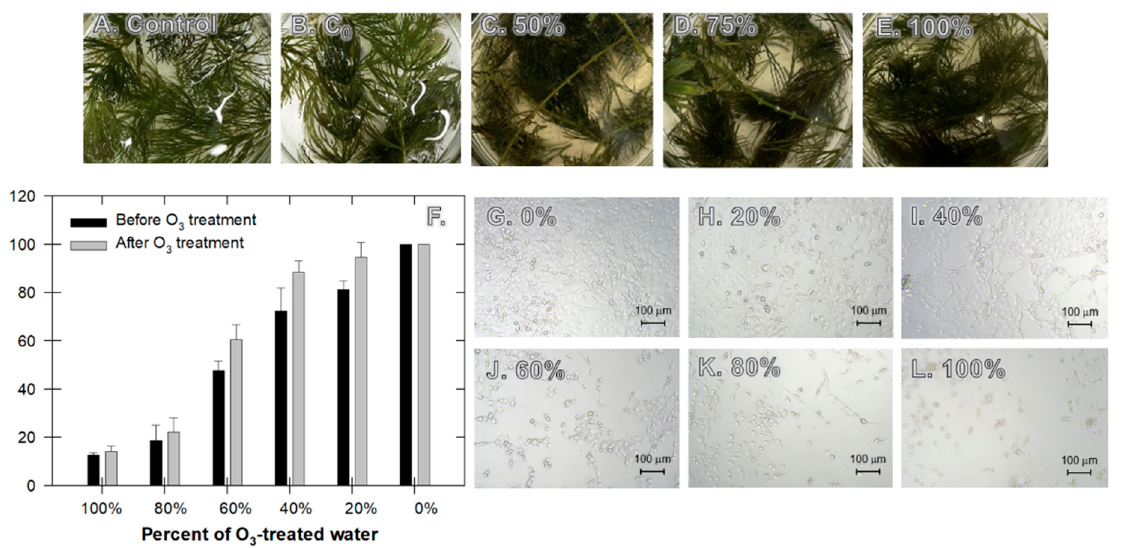
Figure 10. After exposure of samples to different percentages of O 3 -treated water: ( A – E ) visual ob- servation of Ceratophyllum demersum L., ( F ) cytotoxicity assay of Eker Leiomyoma Tumor-3 (ELT3) cell line, and ( G – L ) optical microscopy images of ELT3 cells.